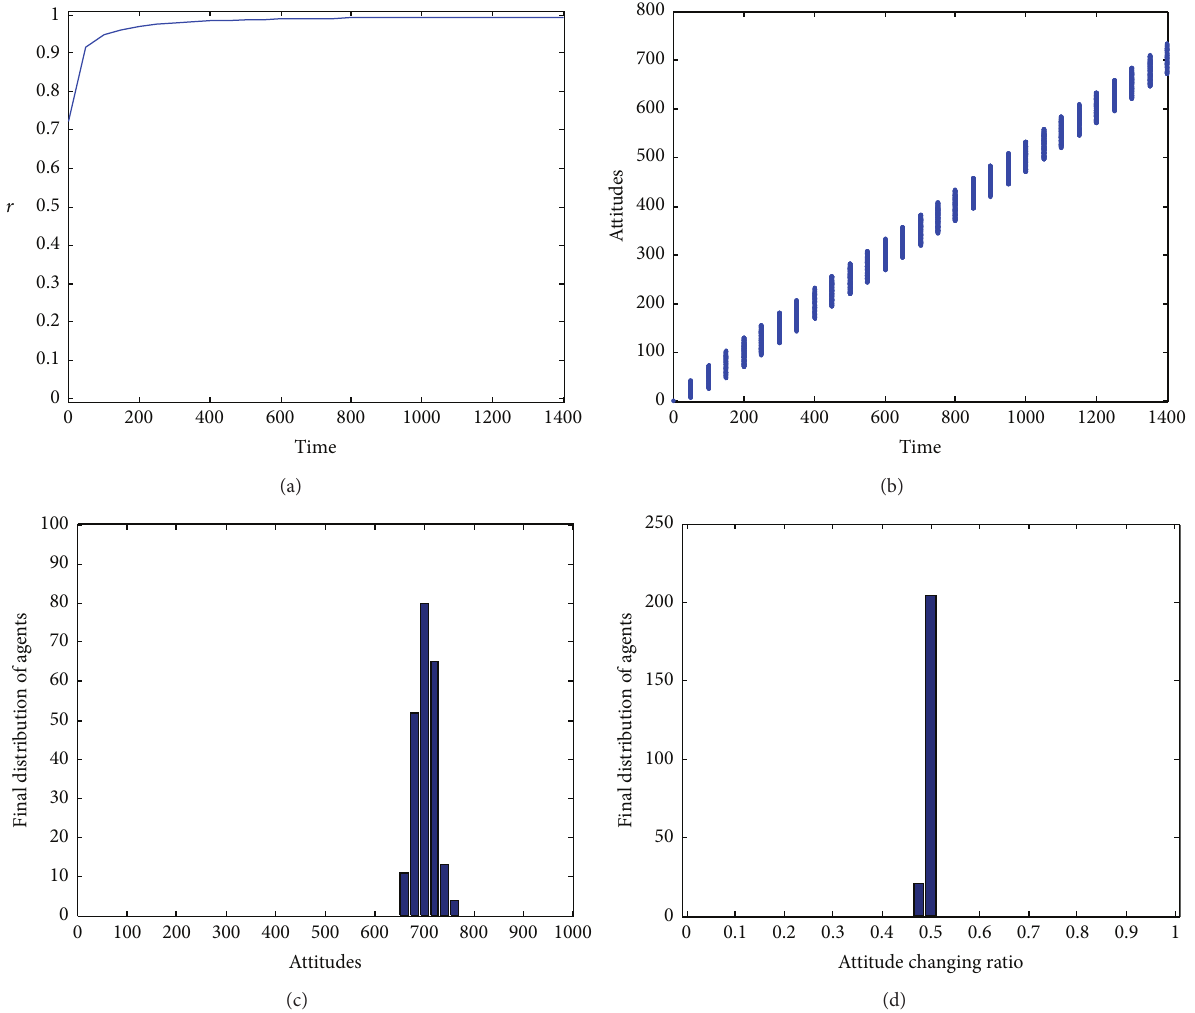
Figure 11: The simulation results with heterogeneous parameters, where 𝛼 and 𝑤 satisfy the normal distribution whose mathematical expectation is 1.5 and variance is 0.17. (a) is the subfigure which shows synchronization criterion 𝑟 changes with time; (b) is the subfigure which shows group attitudes 𝑥(𝑡) versus time; (c) is the histogram of the final distribution of agents versus group attitudes 𝑥(𝑡) ; (d) is the histogram of the final distribution of agents versus attitude changing ratio ̇𝑥 𝑖 (𝑡)